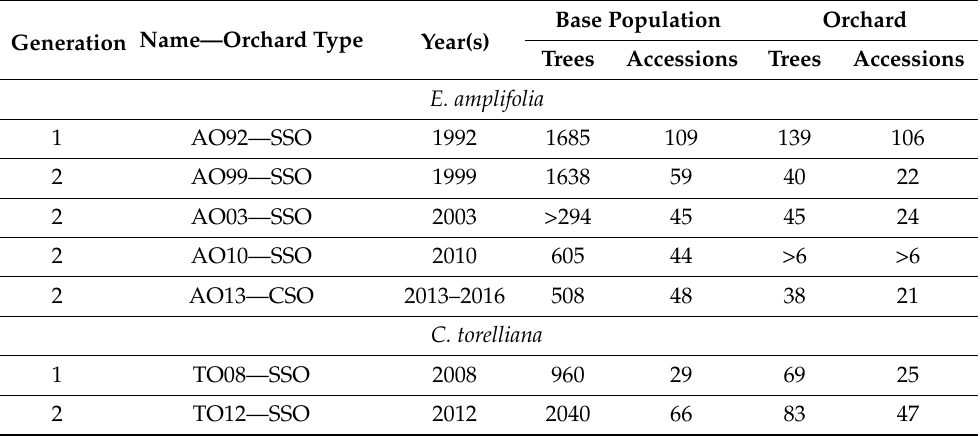
Table 1. Numbers of trees and accessions in Eucalyptus amplifolia and Corymbia torelliana genetic base populations and derived orchards by generation, name and orchard type, and year(s) of establishment adapted from [7].